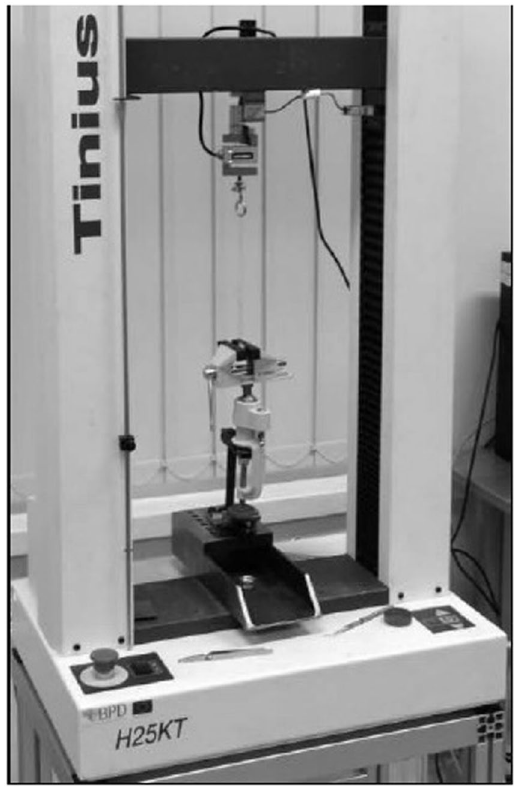
Figure 1. Universal testing machine (Tinius Olsen H25 KT) for the measurement of the tensile bond